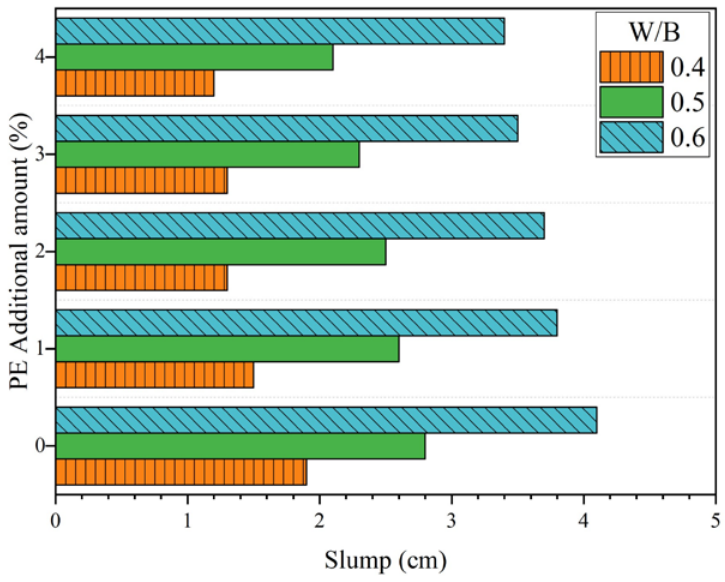
Figure 2. Slump of cement mortar with different W/B ratios and waste PE.